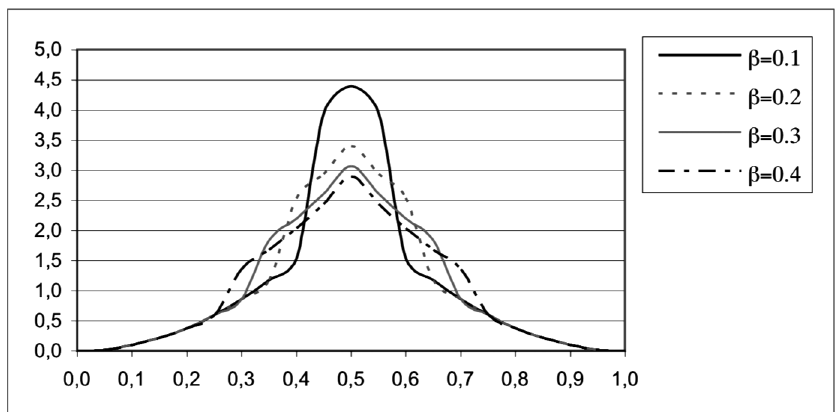
Figure 9 – Symmetric MTSP density ( κ =3 , α =0.2 , β